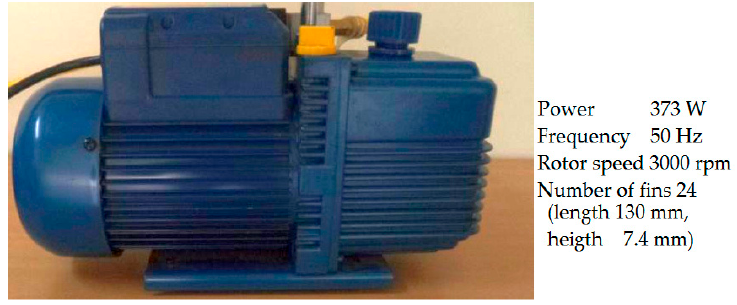
Figure 1. Vacuum pump